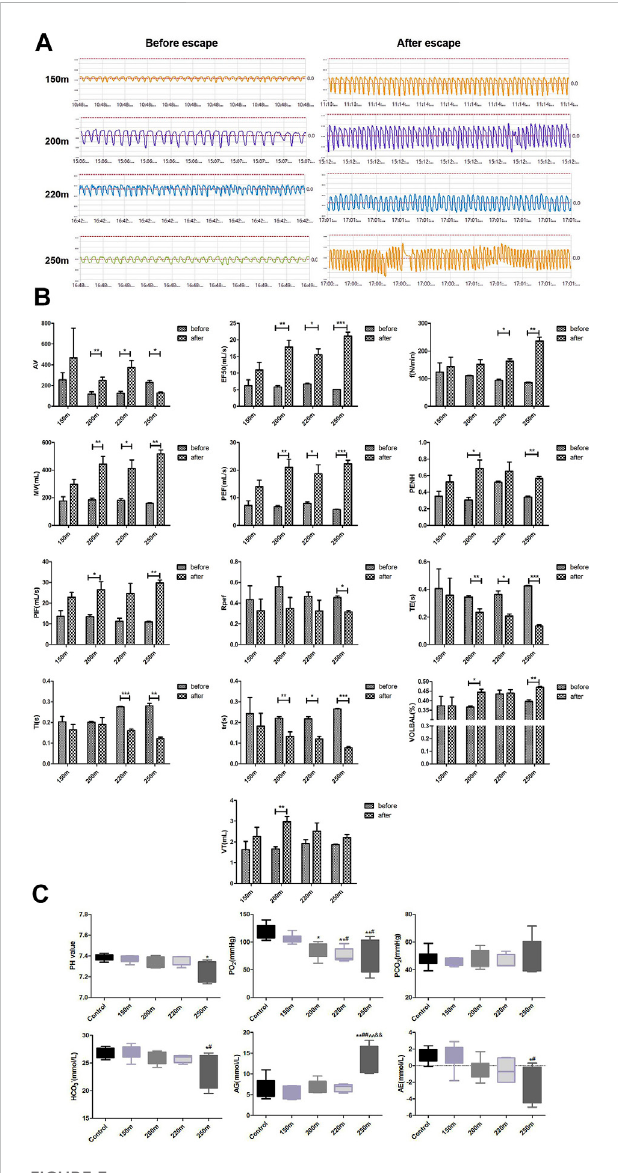
FIGURE 3 Effectofdepthofsimulatedsubmarinetowerescapeonpulmonary function and acid – base status. (A) Respiration waveforms of rats before and after escape. (B) Lung function indexes before and after escape. Paired t -test was performed based on the normality of the distribution by Kolmogorov – Smirnov test. Results are minimum to maximum values ( n = 4 – 6 per group). * p < 0.05, ** p < 0.01, *** p < 0.001 compared to before escape. (C) Effect of depth of simulated submarine tower escape on acid – base status. One-way ANOVA was performed based on the normality of the distribution by Kolmogorov – Smirnovtest.Resultsaretheminimumtomaximumvalues ( n = 5 – 7 per group). * p < 0.05, ** p < 0.01 compared to the control; # p